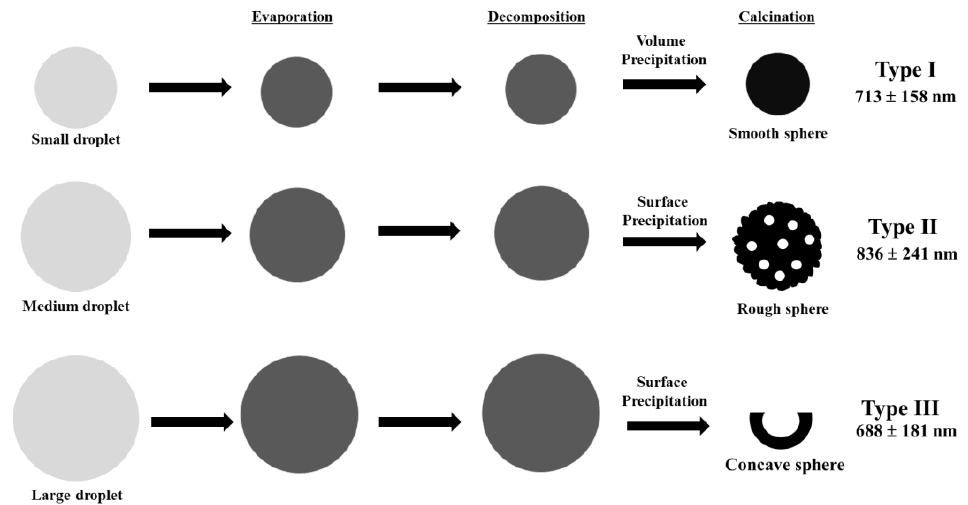
Figure 8. Schematic diagram illustrating the formation mechanism of the main particle morphology of Mg 2 SiO 4 powders for SP stages.